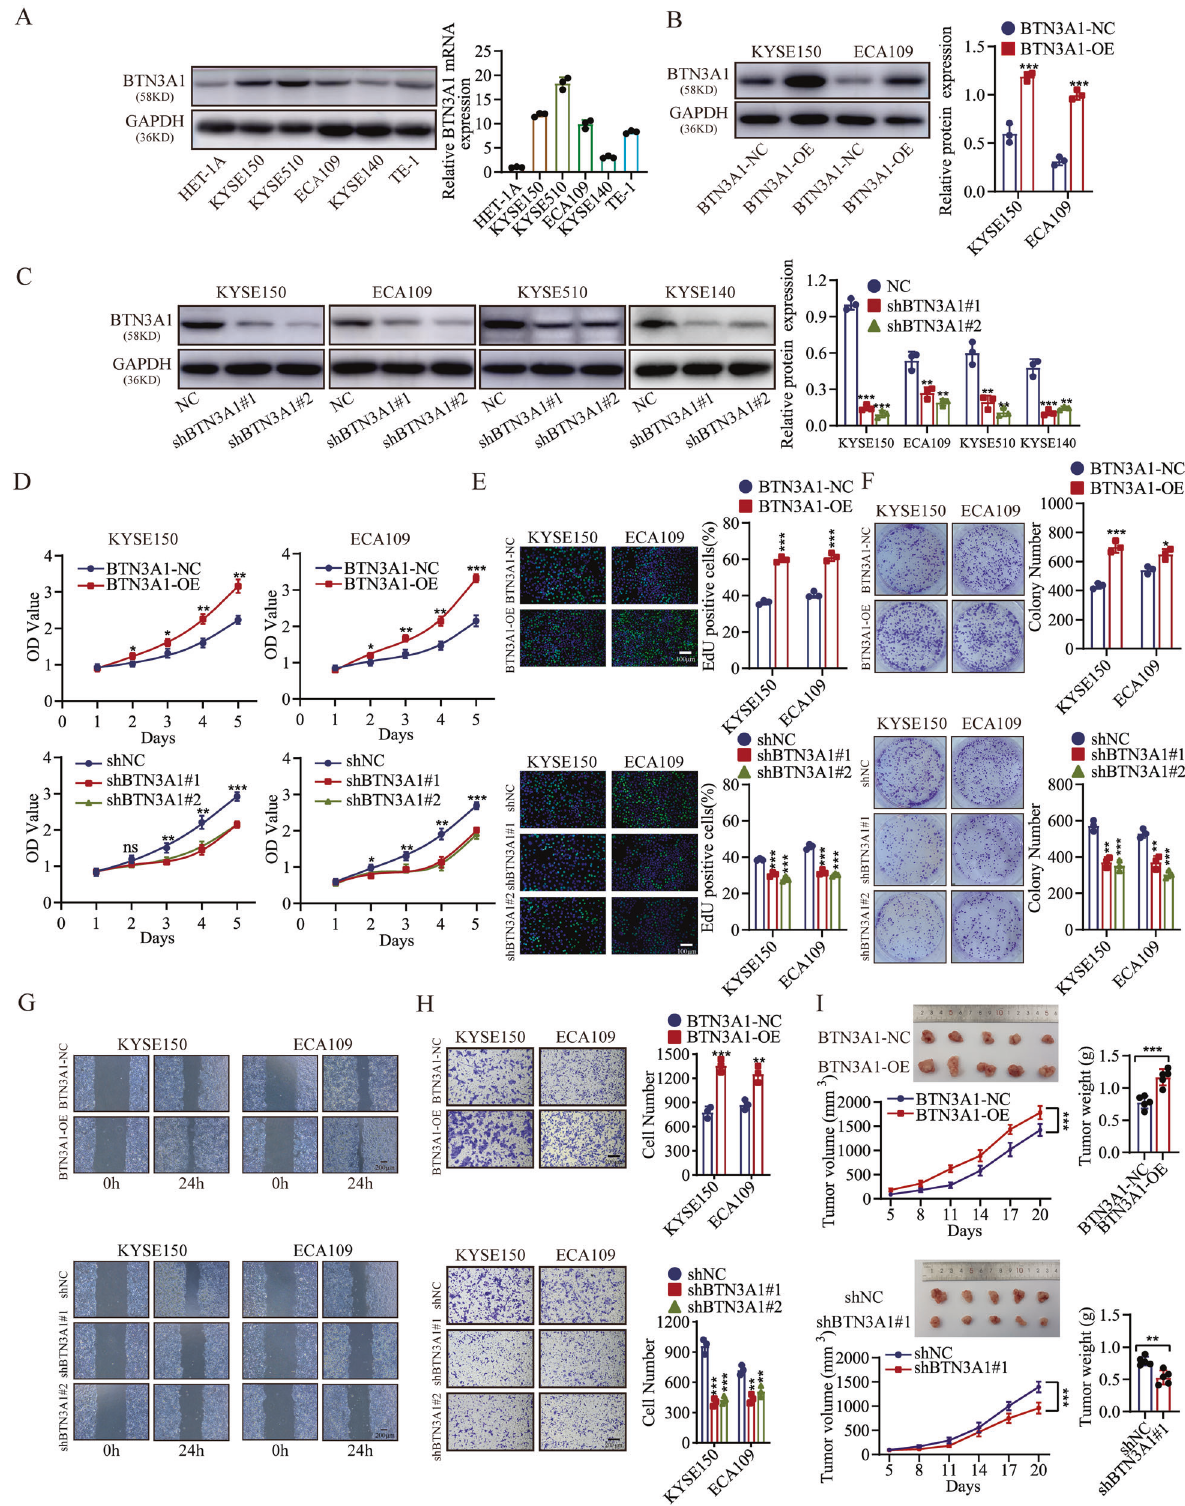
expression promoted tumor cell growth in vitro and in vivo. To the best of our knowledge, the effect of BTN3A1 expression on radiotherapy resistance has not been reported previously. Here, radiation induced an increase in BTN3A1 expression, Cell Death and Disease (2022)